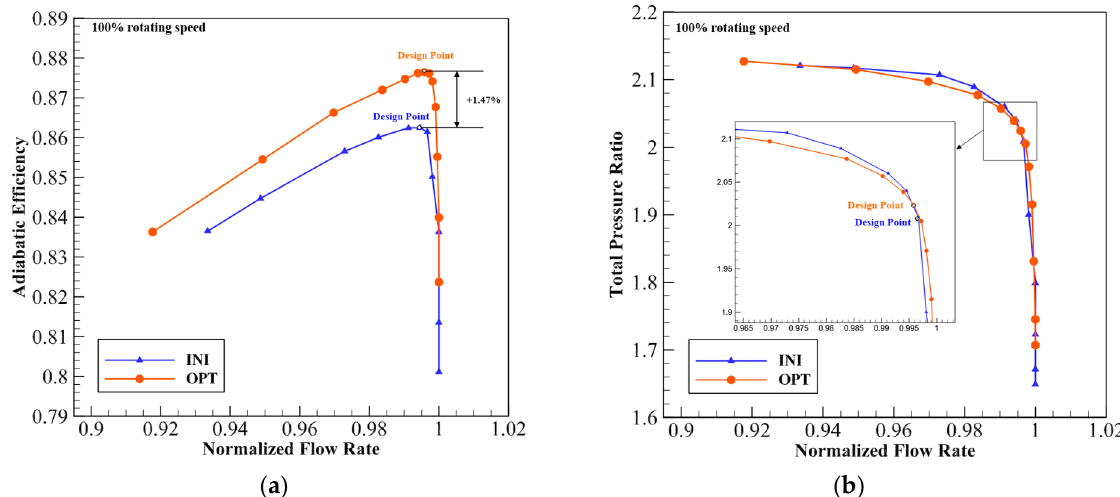
Figure 11. The characteristic lines of optimized and initial blade. ( a ) The performance of adiabatic efficiency. ( b ) The performance of total pressure ratio.